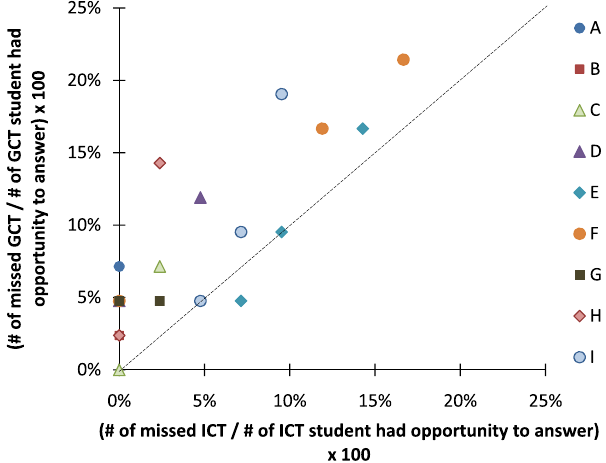
FIG. 11. The x axis denotes the number of times each student did not respond to an ICT divided by the number of ICT the student had the opportunity to answer × 100% ; the y axis denotes the number of times each student did not respond to a GCT divided by the number of GCT the student had the opportunity to answer × 100% for each student. The average standard error for missed ICT percentage was (cid:2) 1 . 19 % and for missed GCT percentage was (cid:2) 1 . 36 %.